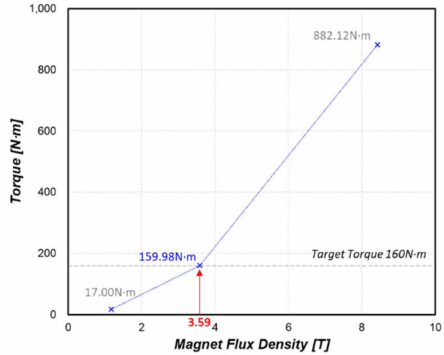
Figure 8. Torque vs. magnetic flux density plot.